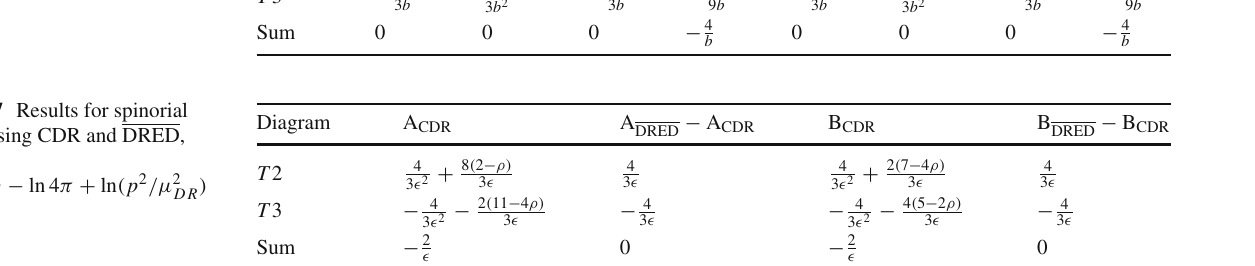
(cid:22) (cid:21) − p 2 λ 2